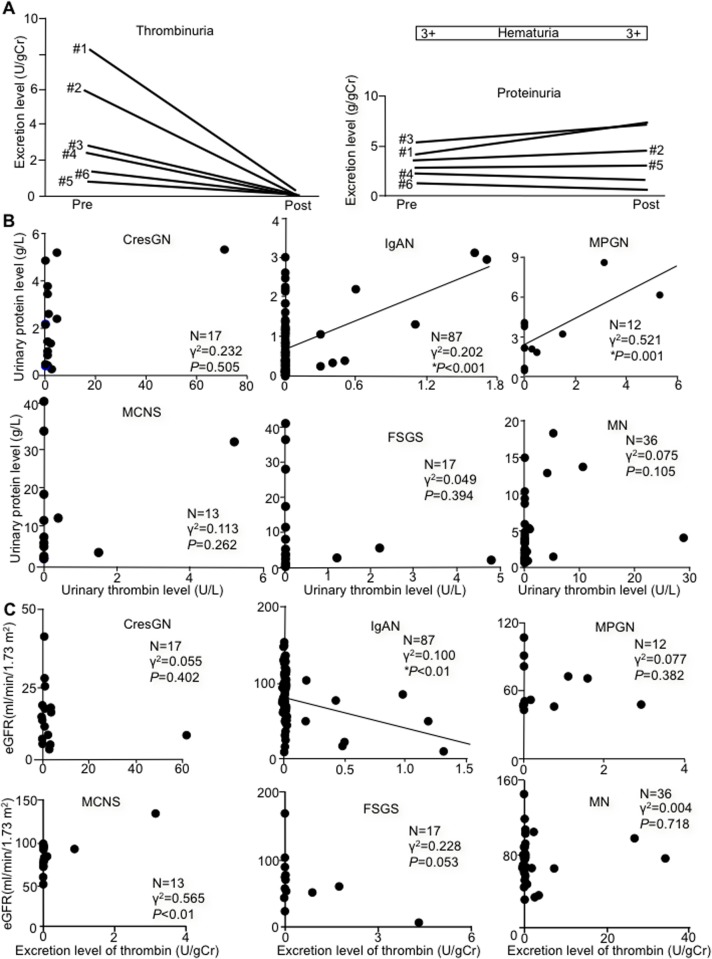
Glucocorticoid effect on thrombinuria and proteinuria and thrombinuria vs. proteinuria or estimated glomerular filtration rate.(A) Thrombinuria (left panel) and proteinuria and hematuria (right panel) before (pre) and after (post) steroid pulse treatment in 6 patients with crescentic glomerulonephritis (CresGN) (#1 to #6) with thrombinuria. Three days of pulse therapy with intravenous methylprednisolone at 0.5–1 g/day was followed by oral prednisolone at 20–30 mg/day. gCr indicates gram of urinary creatinine. (B) Relation between urinary thrombin and urinary protein levels for various types of glomerulonephritis. Each circle represents an individual patient. (C) Relation between excretion level of thrombin and estimated glomerular filtration rate (eGFR) for various types of glomerulonephritis. Each circle represents an individual patient. IgAN, IgA nephropathy; MPGN, membranoproliferative glomerulonephritis; MCNS, minimal change glomerulopathy; FSGS, focal segmental glomerulosclerosis; and MN, membranous glomerulopathy. In (B) and (C), asterisks (*) and solid lines indicate statistically significant associations and correlation lines, respectively.